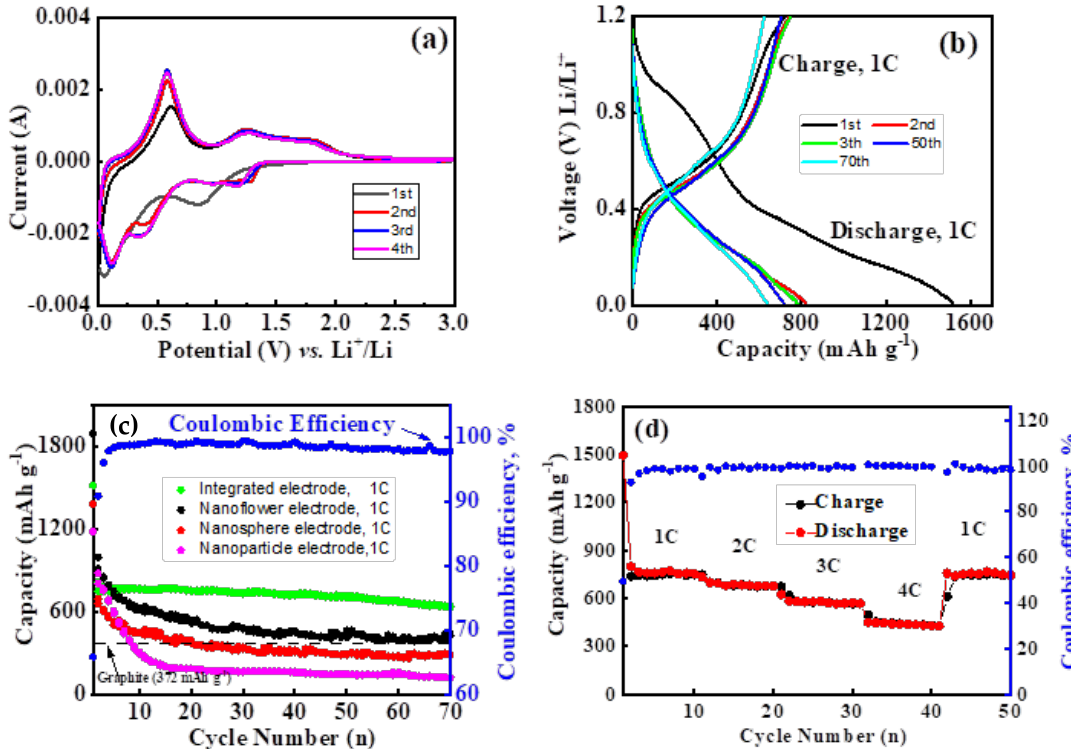
Figure 6. ( a ) Cyclic voltammograms (CVs) of nanosheet-assembled SnO 2 -integrated electrode; ( b ) discharge–charge voltage profile of nanosheet-assembled SnO 2 -integrated electrode between 0.01 and 1.2 V at a rate of 1 C; ( c ) cycling performance and coulombic efficiency (CE) of nanostructured SnO 2 electrode; ( d ) cycling performance at different rates (1–4 C) of nanosheet-assembled SnO 2 -integrated electrode.